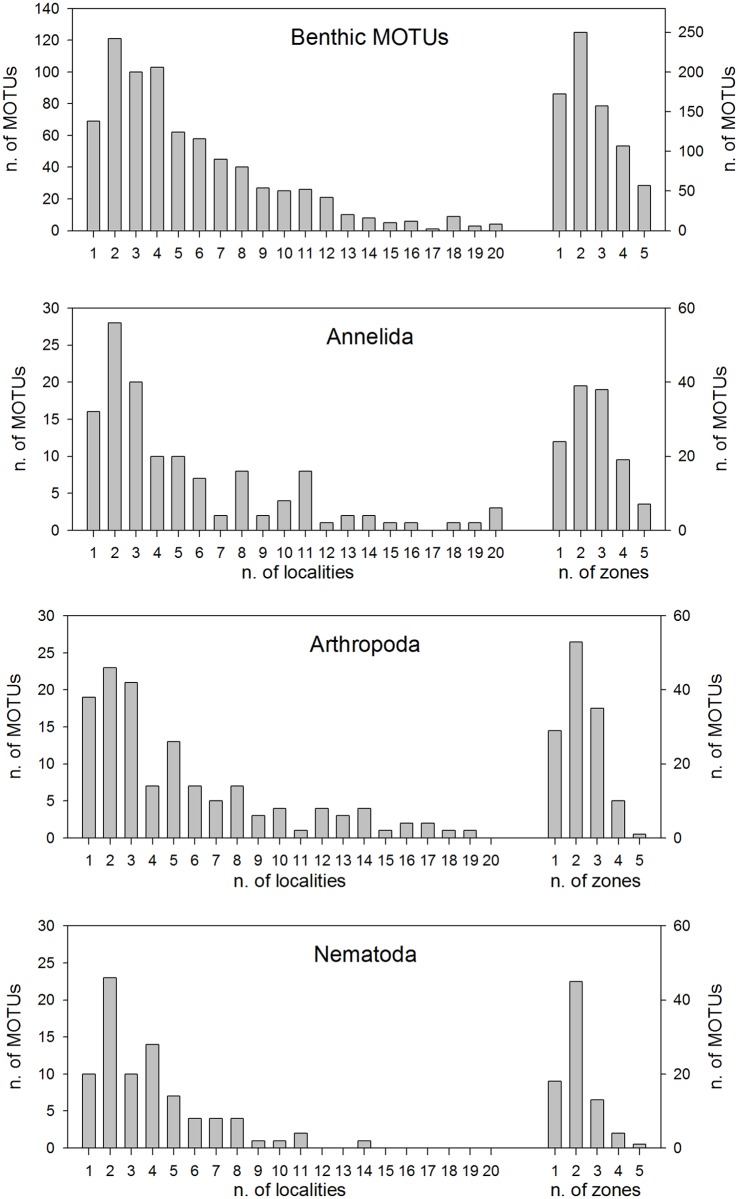
Distributional span of the MOTUs of the benthic taxa and the main metazoan phyla analysed.The graphs represent the frequency histograms of the number of MOTUs present in 1 to 20 samples (left axis), or in 1 to 5 zones (right axis).